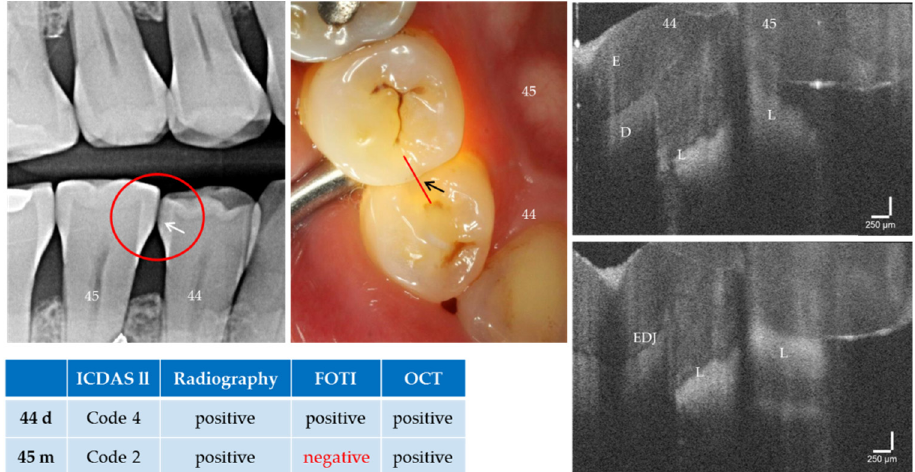
Figure 8. Contingency tables. Highest diagnostic score 1 resulting from the introduced methods radiology/fiber ‐ optic transillumination (FOTI)/visual inspection ( a ) or from radiology/FOTI ( b ) compared to OCT (64 surfaces).